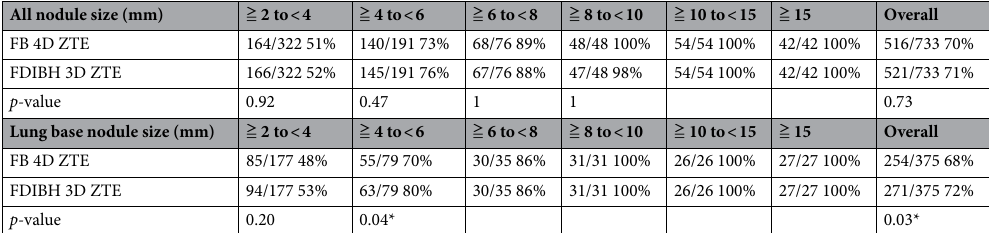
Table 4. All nodule and lung base nodule detection rate according to lung imaging technique. FB 4D ZTE Free-breathing four-dimensional zero echo time; FDIBH 3D ZTE Fractionated deep-inspiration breath-hold three-dimensional zero echo time. *Difference is statistically